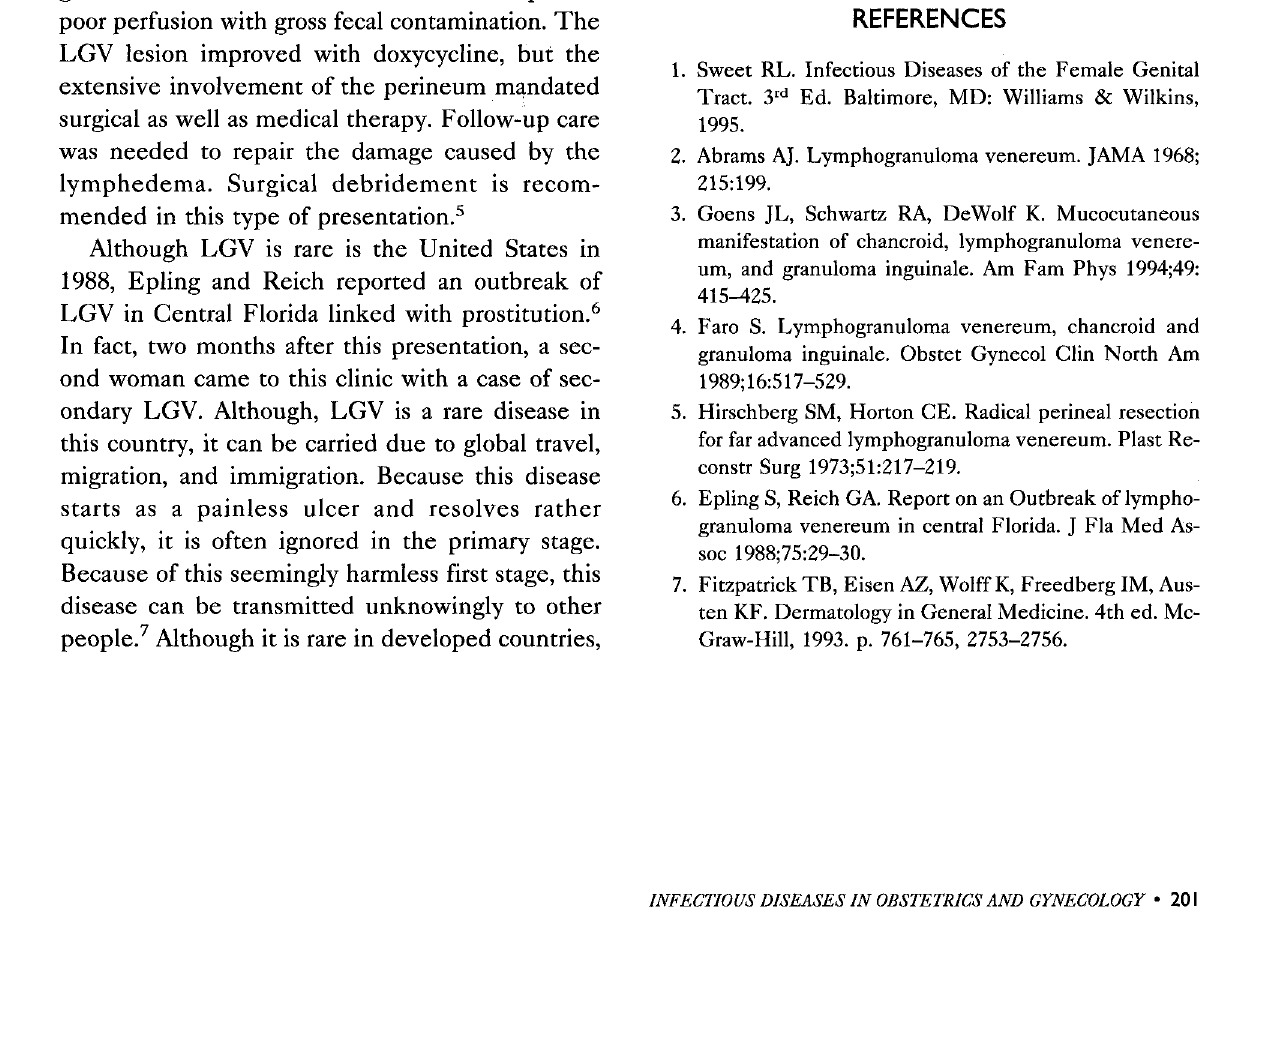
Fig. 2. Operator’s fingertip visible through rectovaginal fistula. Multiple sinus tracts visible. dose of 2 g followed by 4 g a day for 10-28